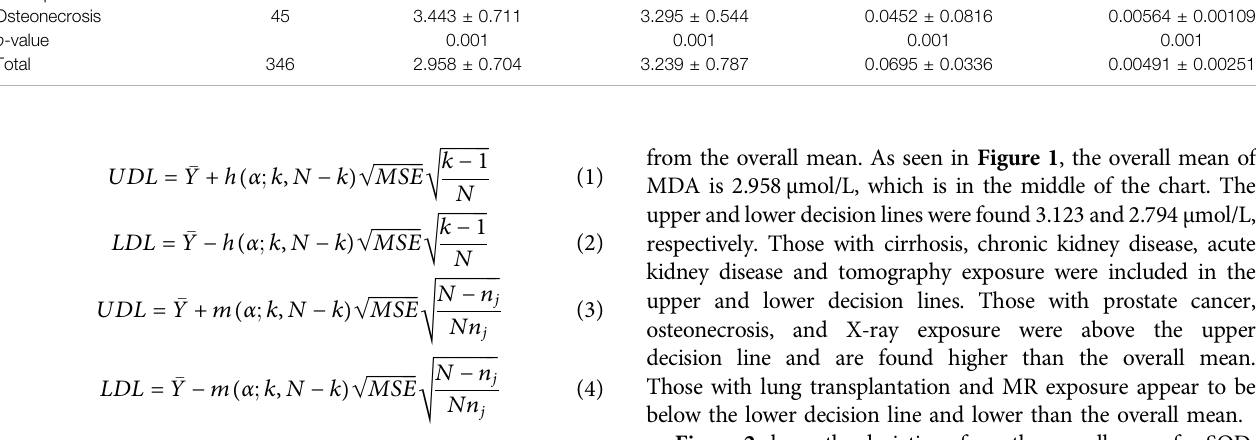
GSH (mmol/g) Mean ± Std. Dev